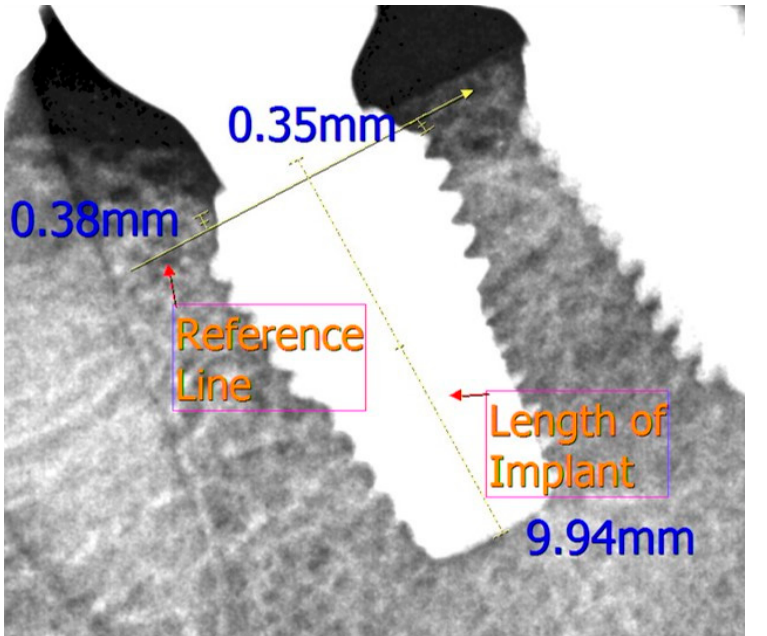
Figure 2. Measurement of the mesial and distal marginal bone level from the reference line in the test